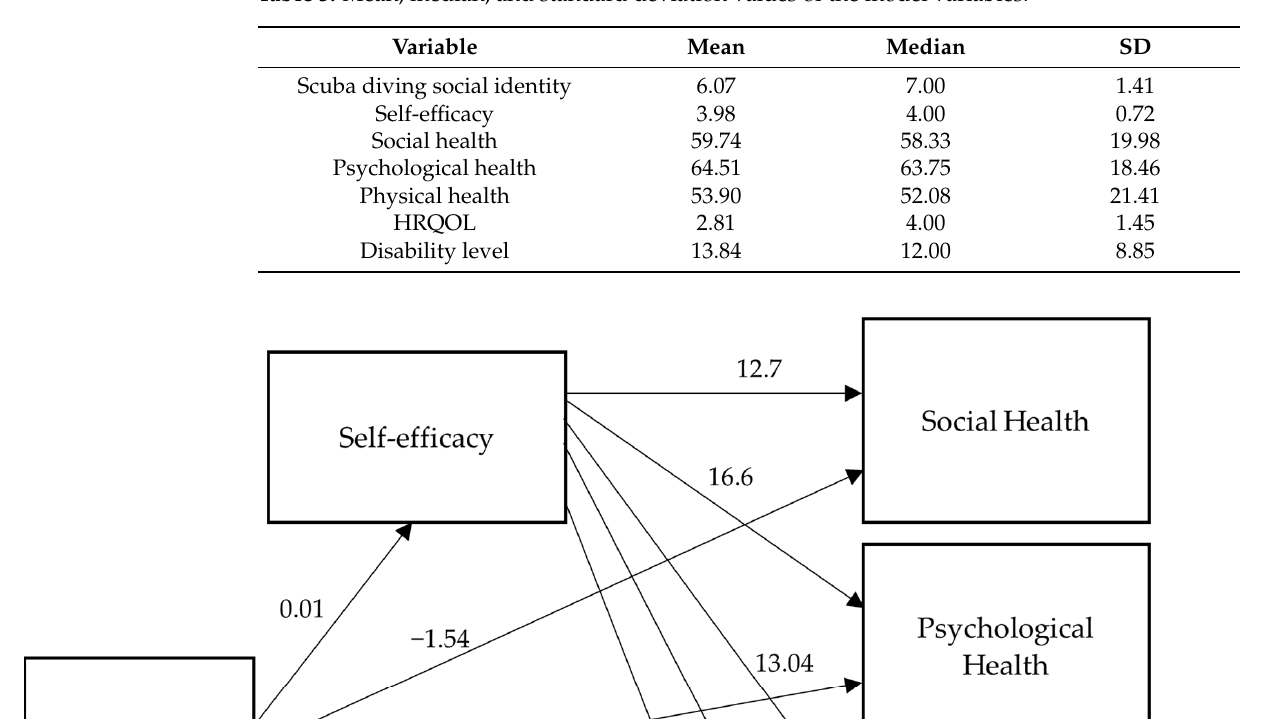
Table 3. Mean, median, and standard deviation values of the model variables.